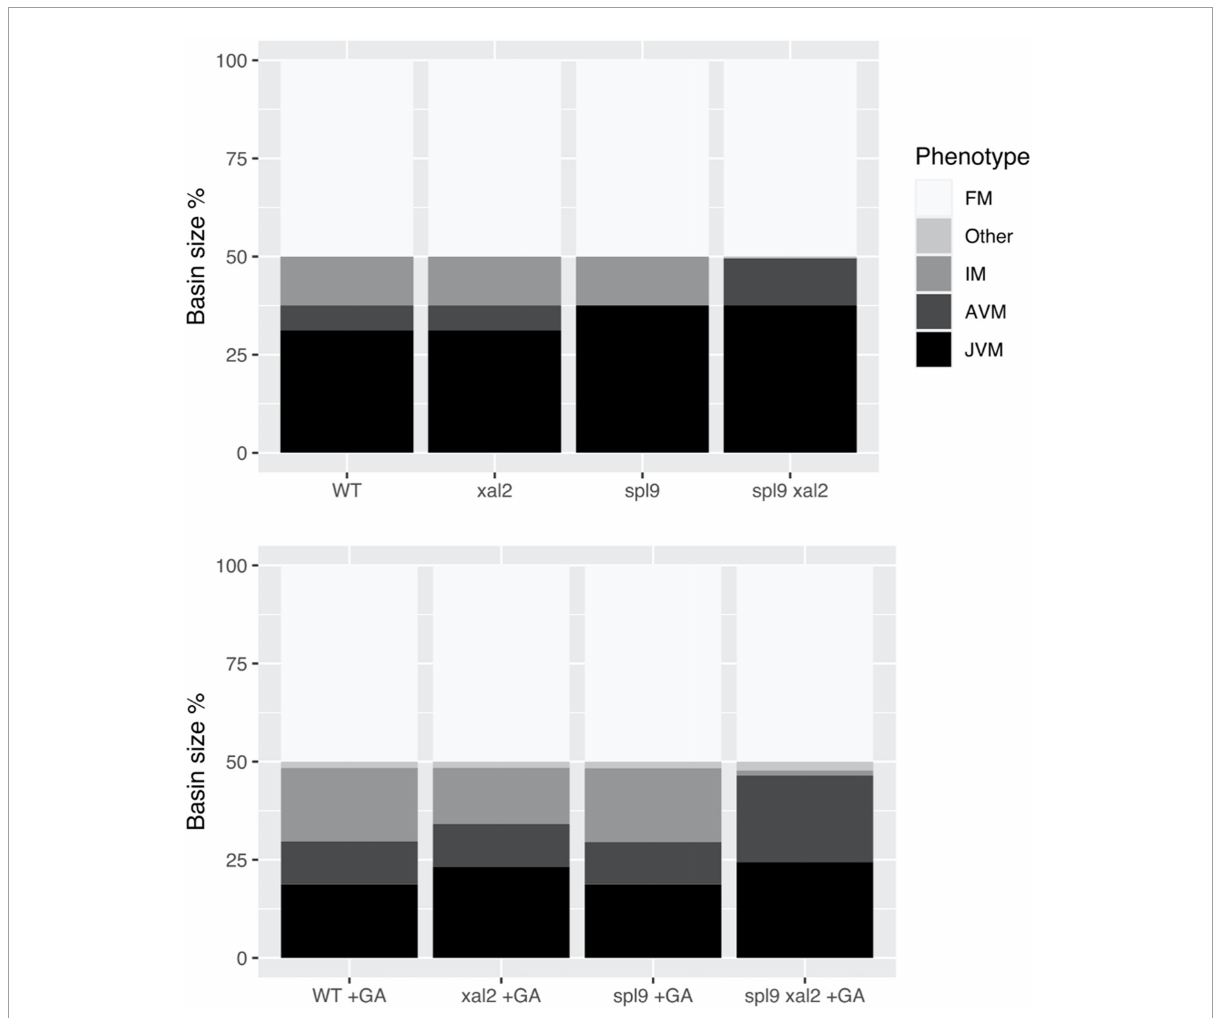
FIGURE7 XAL2 is an important component of the FT-GRN that mediates GA promoting flowering response in SD. We performed mutant simulations in SD with or without GA treatment, fixing the FT-GRN model to simulate SD by keeping the CO input turned off, and GA exogenous treatment was simulated by keeping the GA node turned on. Wild-type, xal2, and spl9 single and double mutants were simulated with (lower panel) or without GA (control, upper panel). For each mutant background under a specific “growth” condition we calculated their attractors, classified them in meristem phenotypes (JVM, AVM, IM, FM, and “Other” which were vegetative cyclic attractors), and plotted their relative basin size as a percentage of all the initial state